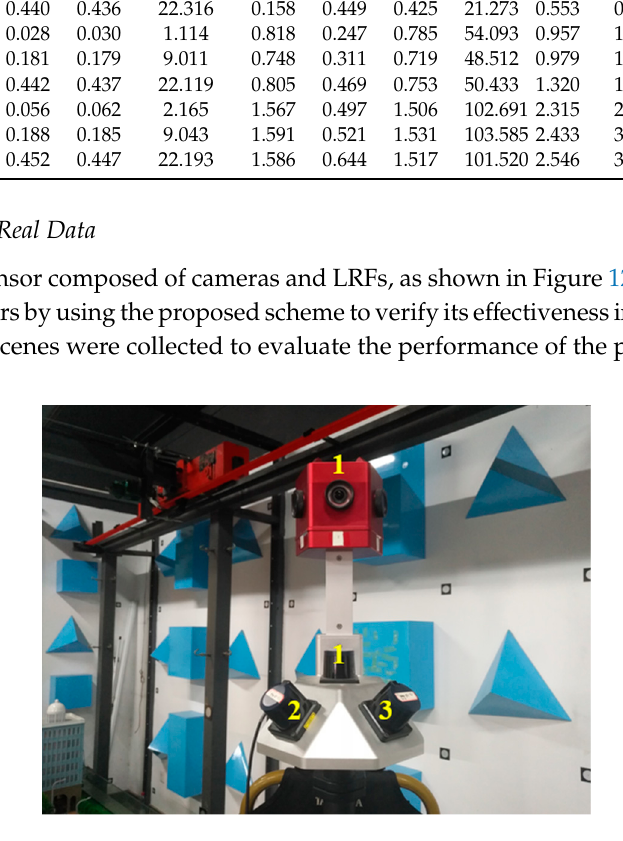
Figure 12. Integrated sensor composed of cameras and LRFs.